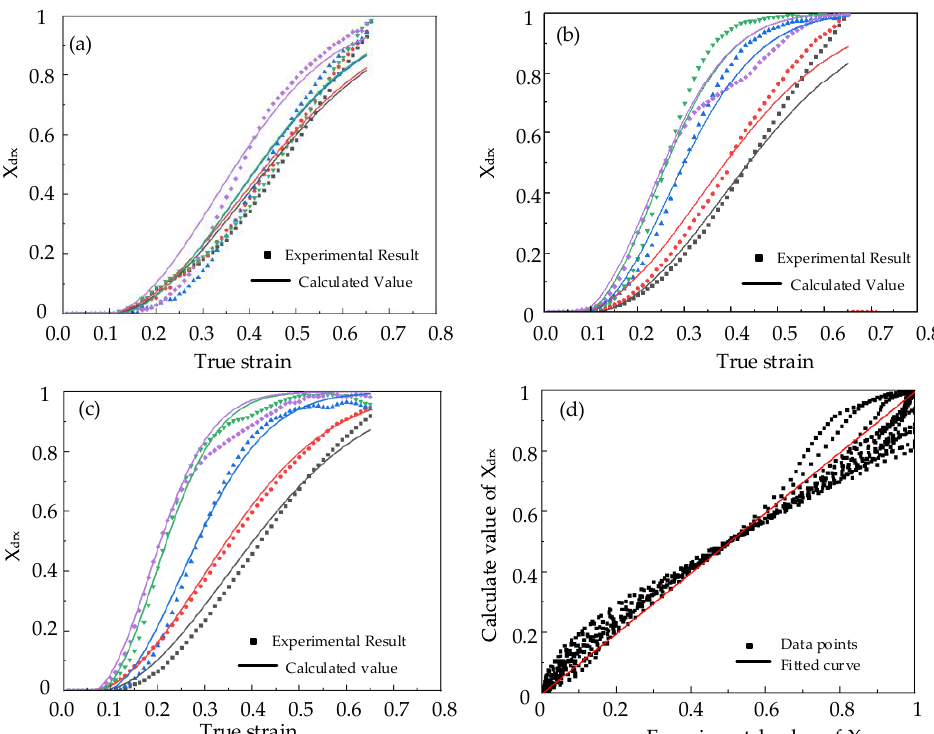
Figure 12. Comparison between calculated model and experimental result of DRX volume fraction: ( a ) ε = 0.1 s − 1 ; ( b ) ε = 0.01 s − 1 ; ( c ) ε = 0.005 s − 1 ; ( d ) Comparison of calculated and experimental values.